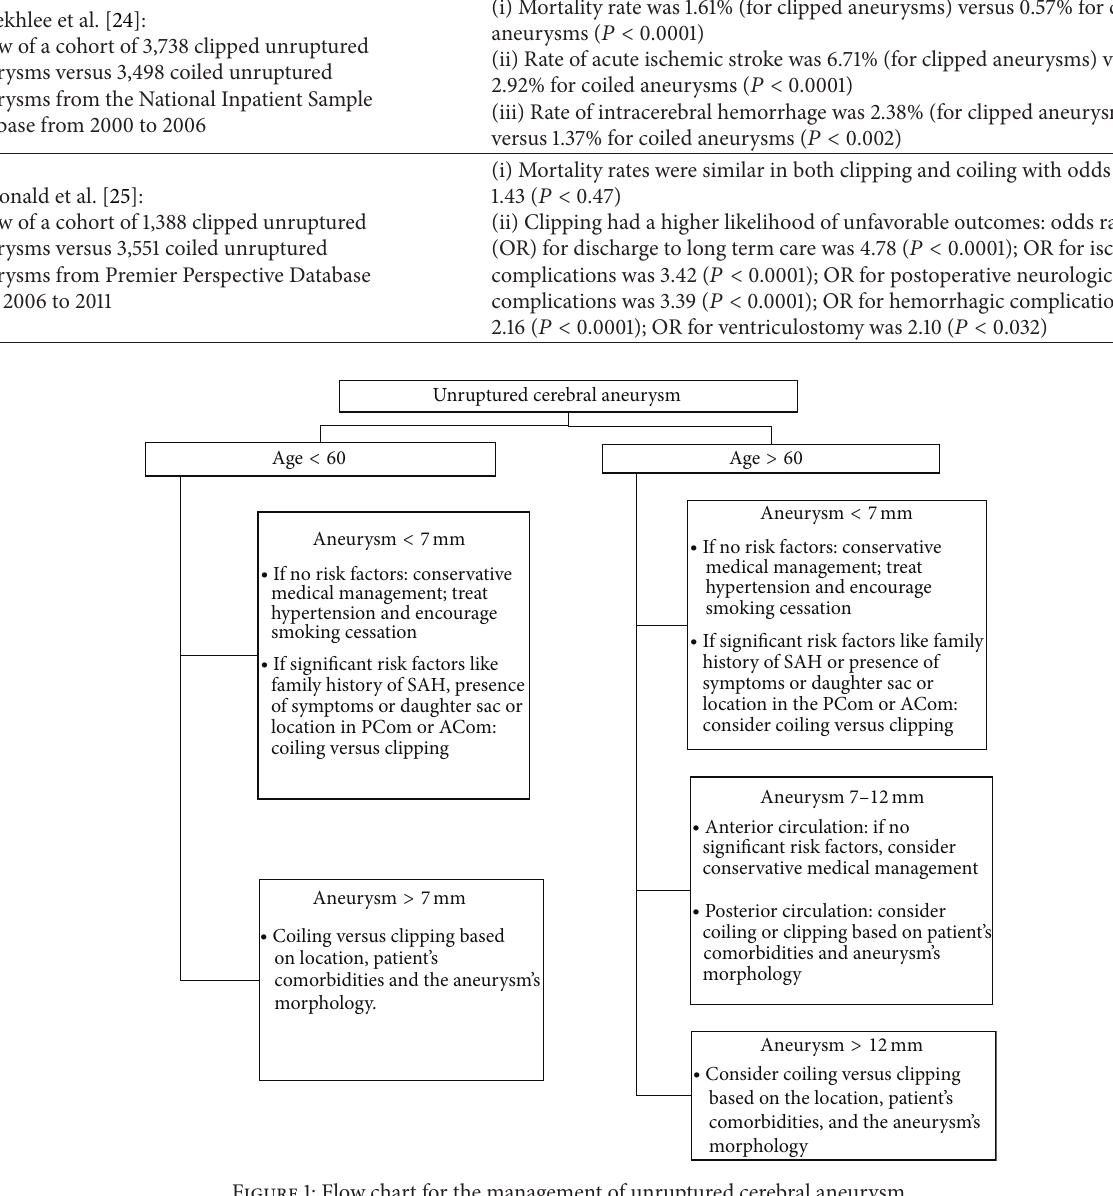
Figure 1: Flow chart for the management of unruptured cerebral